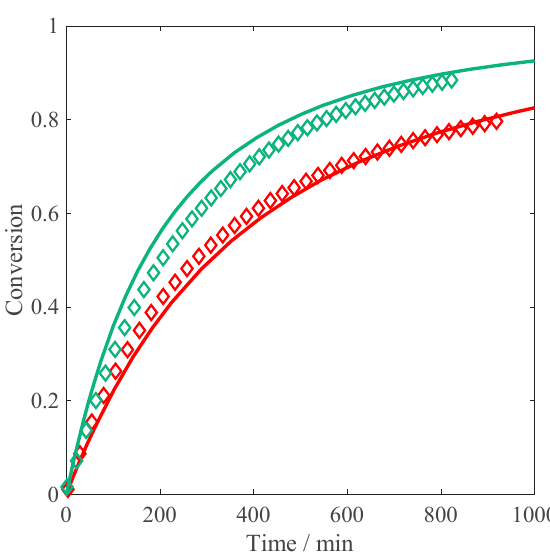
Figure 10. Monomer conversion versus time profiles of the radical batch polymerization of fully ionized MAA in aqueous solution at 50 ◦ C, 0.1 wt % of V-50 initiator and constant ionic strength equivalent to 5 wt % MAA by the addition of NaCl. Variation of monomer concentration 1 wt % (red) and 5 wt % (green, no NaCl addition): comparison between experimental data by in-situ NMR (diamonds) and simulated curves (lines, using parameter values of Table 6).